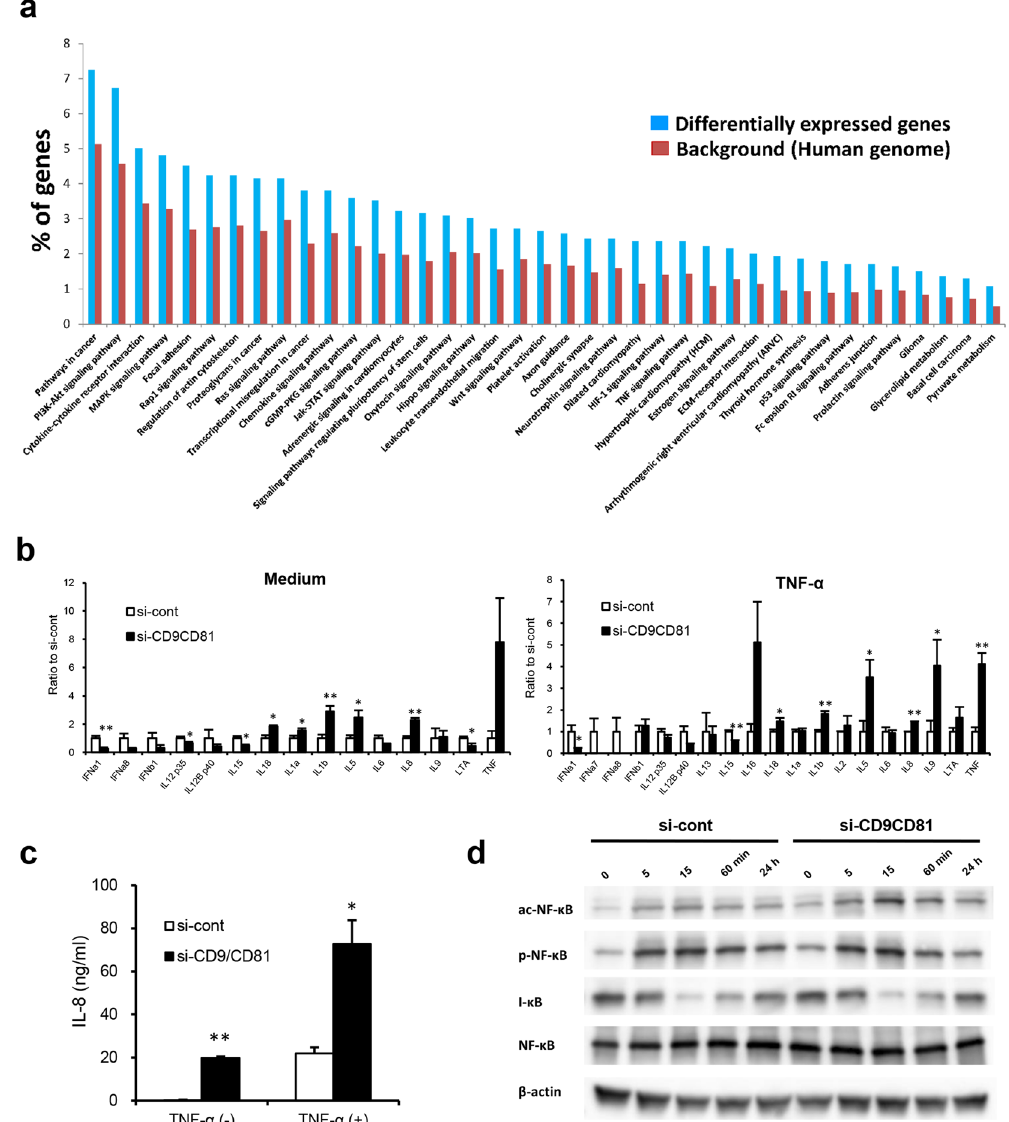
Figure 7. Double deletion of CD9/CD81 increases inflammation. ( a ) DNA microarray analysis of CD9/CD81 DKD epithelial cells using TargetMine revealed enriched KEGG pathways, including inflammation-associated and proliferative pathways (n = 3). ( b ) Real-time PCR analysis of epithelial cells using a TaqMan Array Plate (Human Cytokine Network) revealed that CD9/CD81 DKD upregulated the gene expression of inflammatory cytokines such as IL-1 β , IL-8, and TNF- α (n = 3). ( c ) CD9/CD81 DKD epithelial cells exhibited elevated IL-8 production (n = 3). ( d ) Kinetics of NF- κ B and acetylated or phosphorylated NF- κ B induced by TNF- α in A549 epithelial cells. DKD of CD9 and CD81 increased the levels of acetylated NF- κ B. Bars represent means ± SD; * P < 0.05, ** P < 0.01 versus